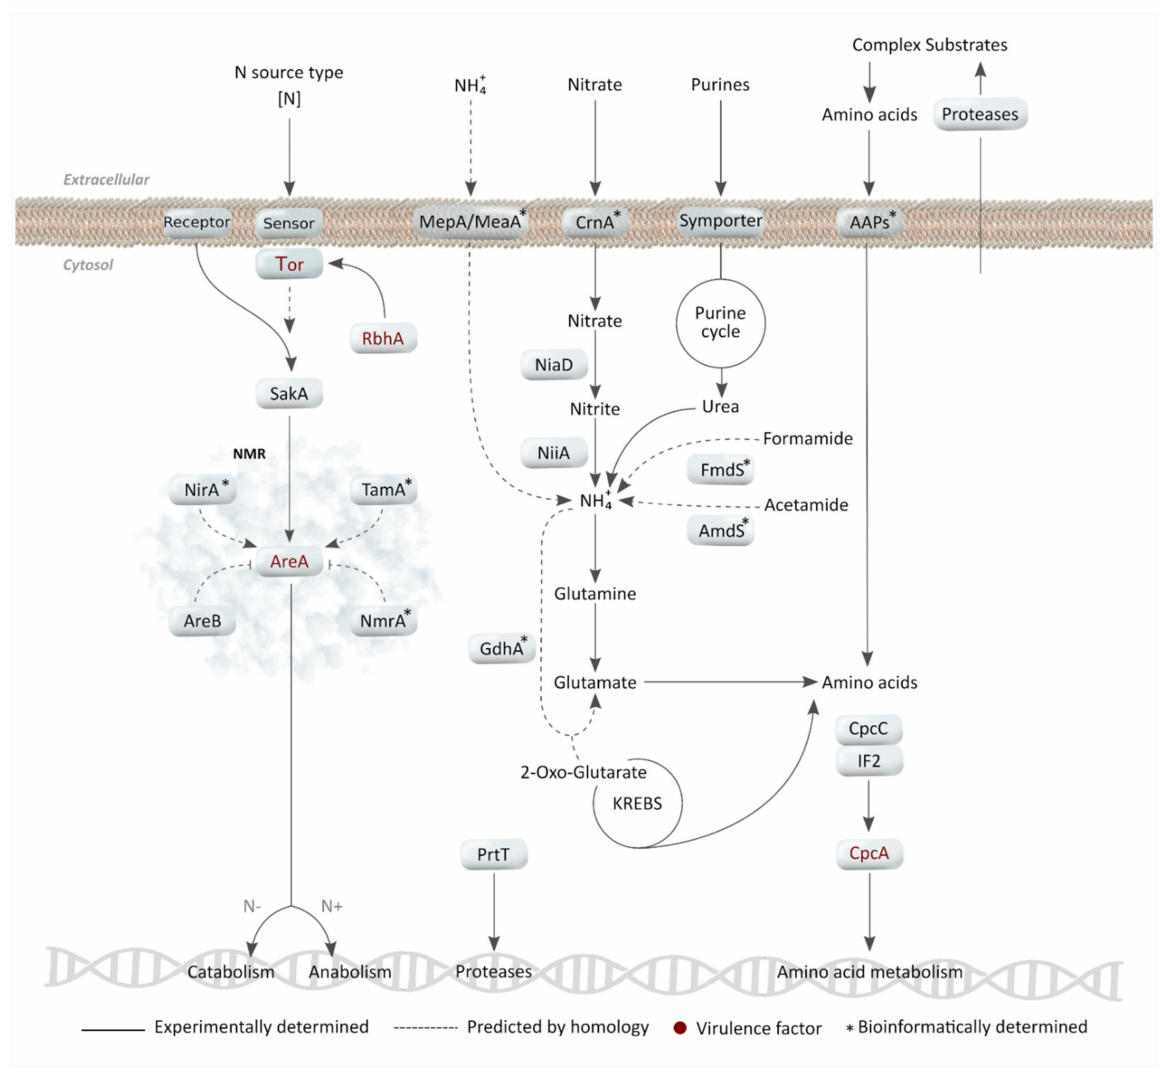
Figure 1. Nitrogen sensing, uptake, metabolism, and regulation in A. fumigatus . Each receptor is in charge of sensing and importing a form of extracellular nitrogen. All forms then reach a common step, the transformation to ammonium. This molecule is incorporated into the glutamate pool, the precursor of all other amino acids. Nitrogen metabolite repression (NMR) positively regulates nitrogen catabolism with a lack of nitrogen or presence of second sources of nitrogen and anabolisms when ammonium or glutamine is present in the media. The CPC system regulates amino acid